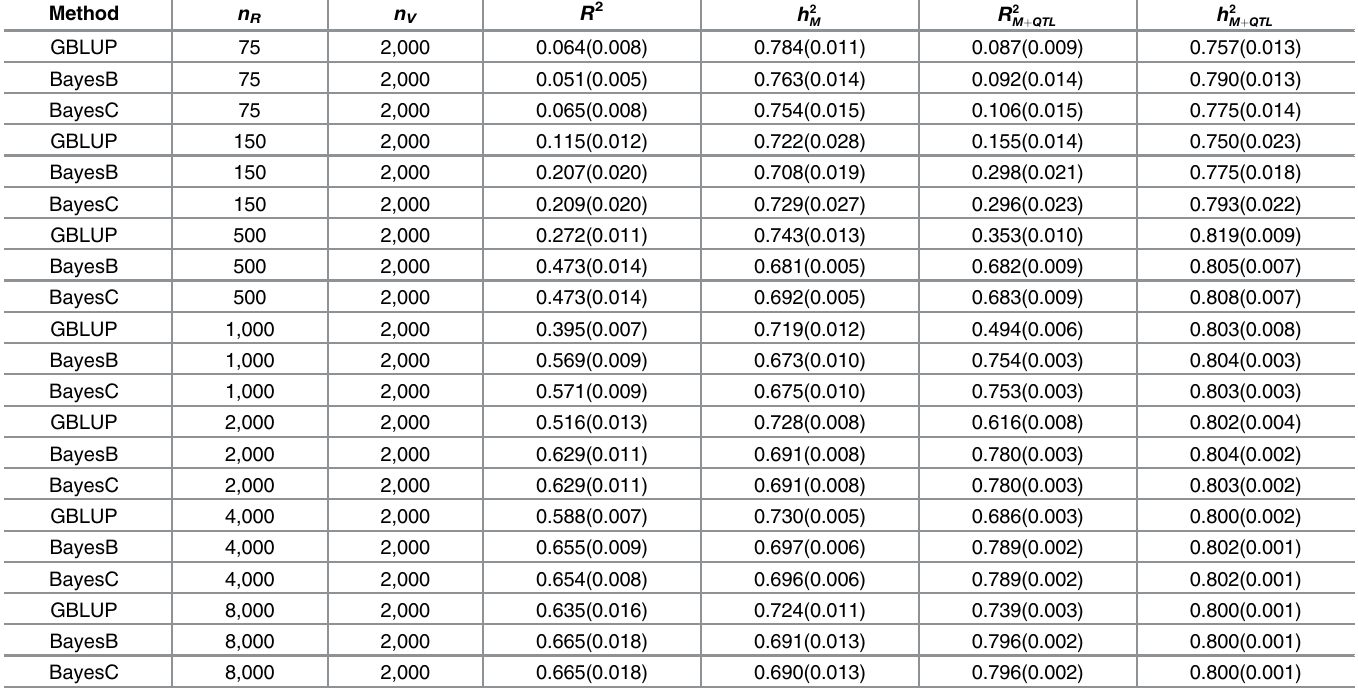
Table 3. Results of